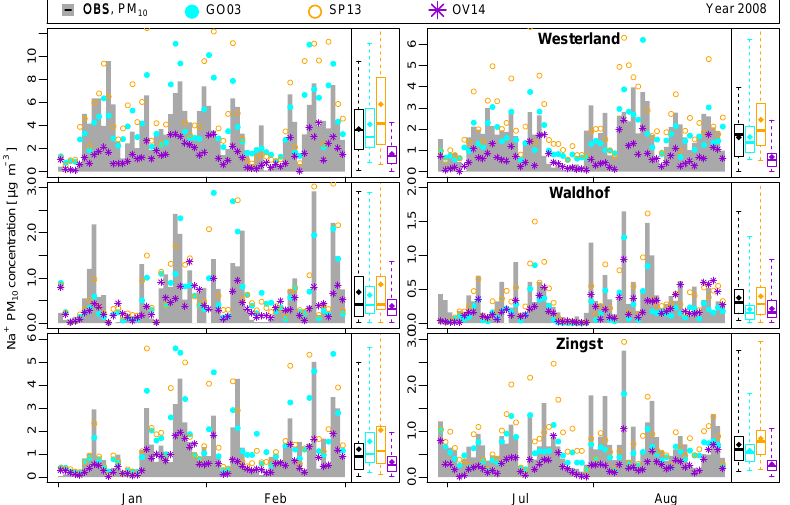
Figure 10. Sodium concentrations at three representative EMEP stations (Westerland, Waldhof and Zingst). The black box plot represents the observations. For the box plots of the modeled data, only the daily model values with corresponding measured values are